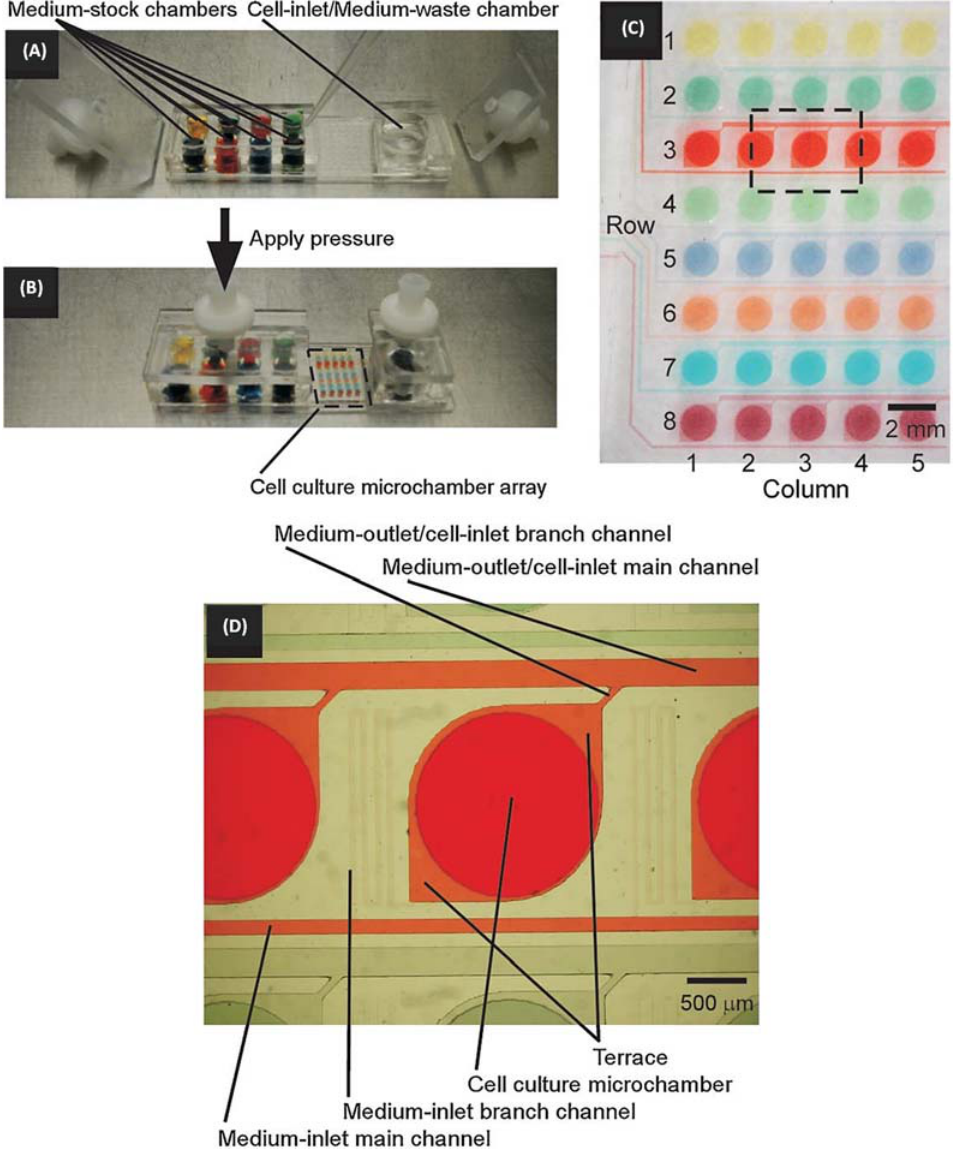
Figure 5. Schematic diagram of a Microfluidic chip driven by pressure: ( A ) Eight different dyes are injected into the Microfluidic chip. ( B ) Pressure is applied by venting from the outside through a sterile ventilation filter, with the dashed line indicating the enlarged area in ( C ). ( C ) Microscopic photograph of the Microfluidic chip, with the dashed square indicating the expanded region in ( D ). ( D ) Three colors indicate three different microstructures. The image from [42], Copyright 2008, Wiley.